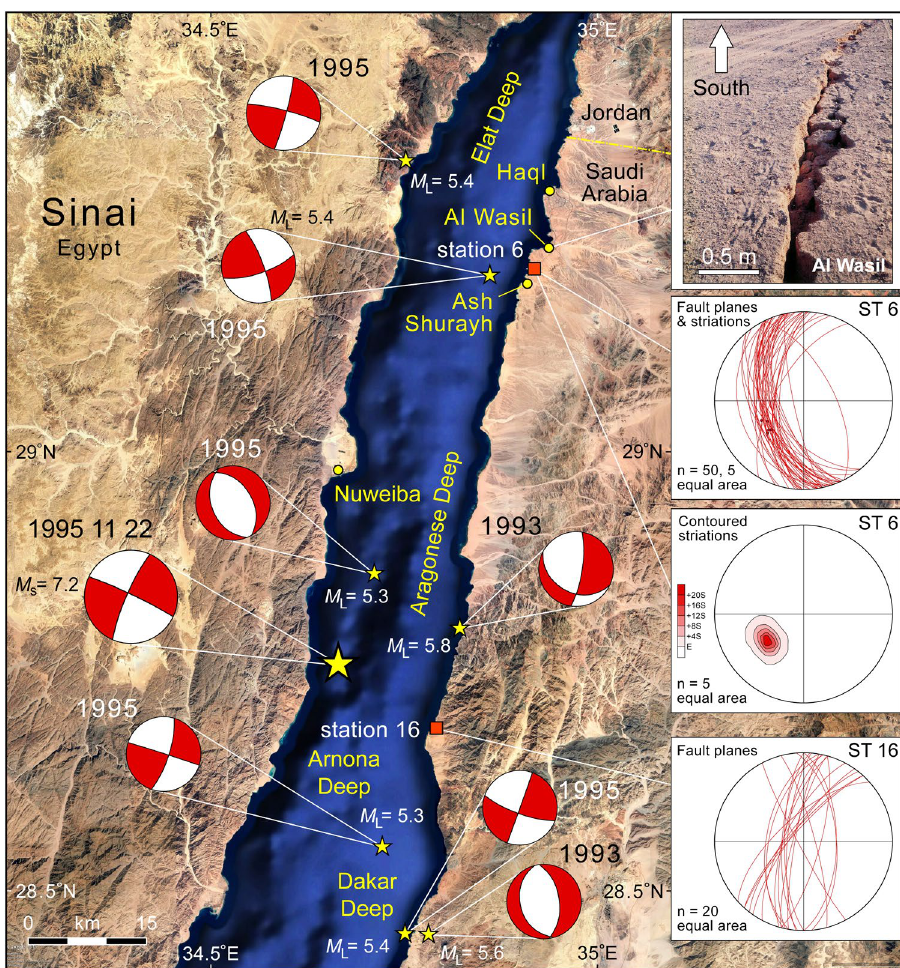
Figure 4. Earthquake focal mechanisms and magnitudes of the November 22, 1995 7.2 M S sinistral strike-slip earthquake (larger symbol), its largest aftershocks, and the two largest events in the 1993 seismic swarm 15 . Several of the events displayed predominantly normal fault mechanisms. The outcrop photograph from near Al Wasil is of a fissure with ~30 cm dip-slip extensional offset (photographed December 2005). Stereoplots are outcrop measurements of small-scale extensional faults from coral terrace station areas 6 and 16 (Fig. 3). In area 6 the faults cut partially lithified Plio-Pleistocene sandstone and conglomerate beds. The average slip direction of the limited kinematic data plunges 46° toward 231° (ENE-WSW extension). No strike-slip faults were observed. The measurements for area 16 are from within the Pleistocene coral terrace but below the actual MIS5e high-stand. No kinematic data were observed at this station but if dip-slip is assumed then the extension was approximately east-west. Location of map is shown in Fig. 3. Basemap data: Google, SIO, NOAA, US Navy, NGA, GEBCO; Image